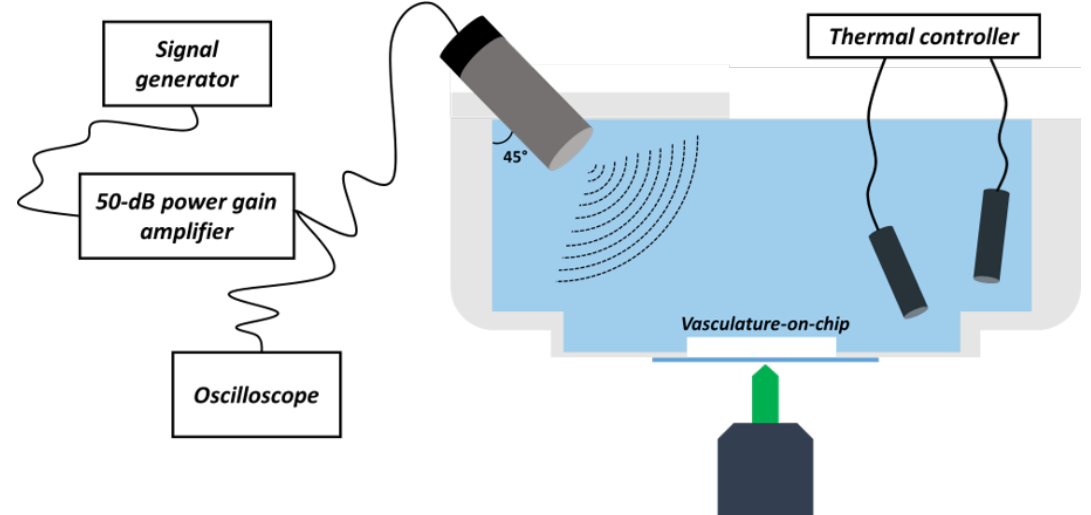
Figure 3. Sketch of the acoustic and optical set-ups of the USMB-induced cavitation experiment showing the integration of the acoustic and optical components (see the Supplementary Material for additional information). The chamber was designed to host the microfluidic device at its bottom, guaranteeing optical access to the microscope objectives. In order to allow US waves to correctly propagate from the 45 ◦ -inclined piezo located at the top, the chamber was filled with deionised water. Water temperature was constantly monitored and maintained at 37 ◦ C with the aid of a thermal controller. The piezo was connected to the US chain, comprising signal generator, 50-dB amplifier, and oscilloscope to monitor the US